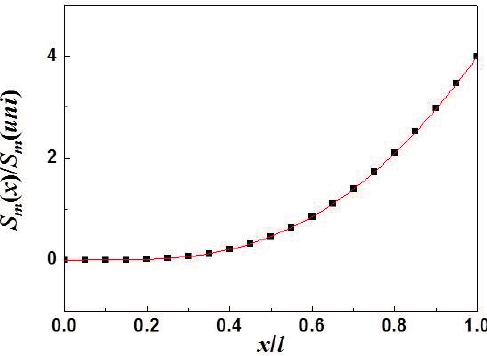
Figure 2. Mass sensitivity ( S m ) of a cantilever with a concentrated mass versus the location ( x ) of the mass, where S m is calculated using the methodology introduced here. The y -axis is normalized as (cid:1845) ((cid:1876)) (cid:1845) (cid:3040)(cid:3048)(cid:3041)(cid:3036) ⁄ , where (cid:1845) (cid:3040)(cid:3048)(cid:3041)(cid:3036) is defined by Equations (1) and (cid:3040)